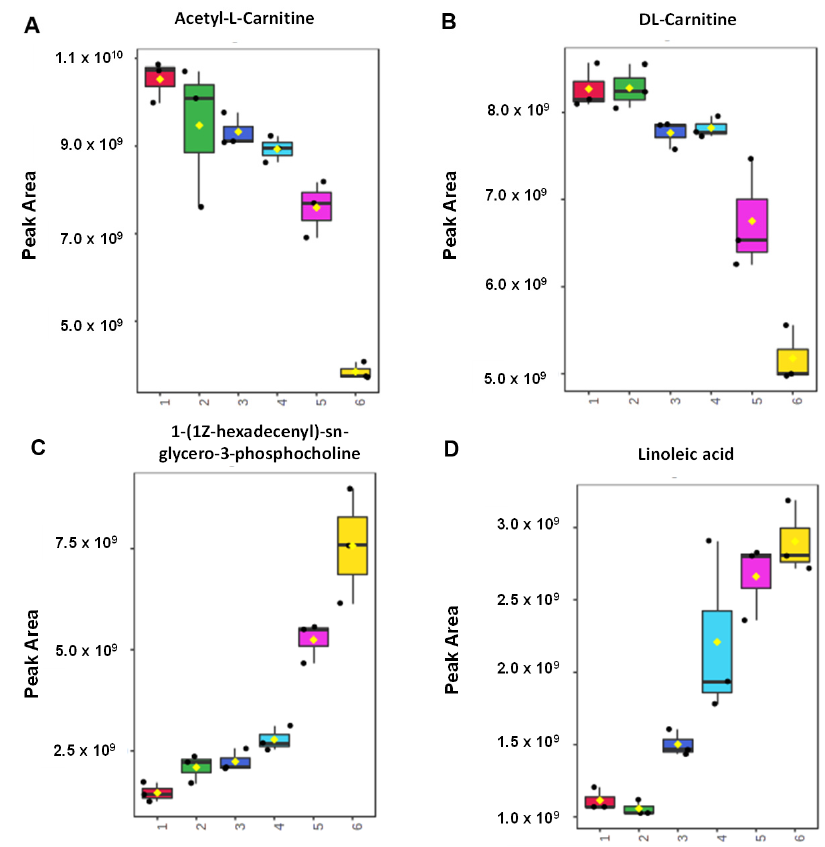
Figure 5. The Box ‐ plot of ( A ) acetyl ‐ L ‐ carnitine, ( B ) DL ‐ carnitine, ( C ) 1 ‐ (1 Z ‐ hexadecenyl) ‐ sn ‐ glycero ‐ 3 ‐ phosphocholine, and ( D ) linoleic acid, obtained from targeted metabolomics analysis using meatball samples containing several concentration levels of pork (1 = 100% beef, 2 = 0.1% pork, 3 = 5% pork, 4 = 25% pork, 5 = 50% pork, 6 = 100% pork).